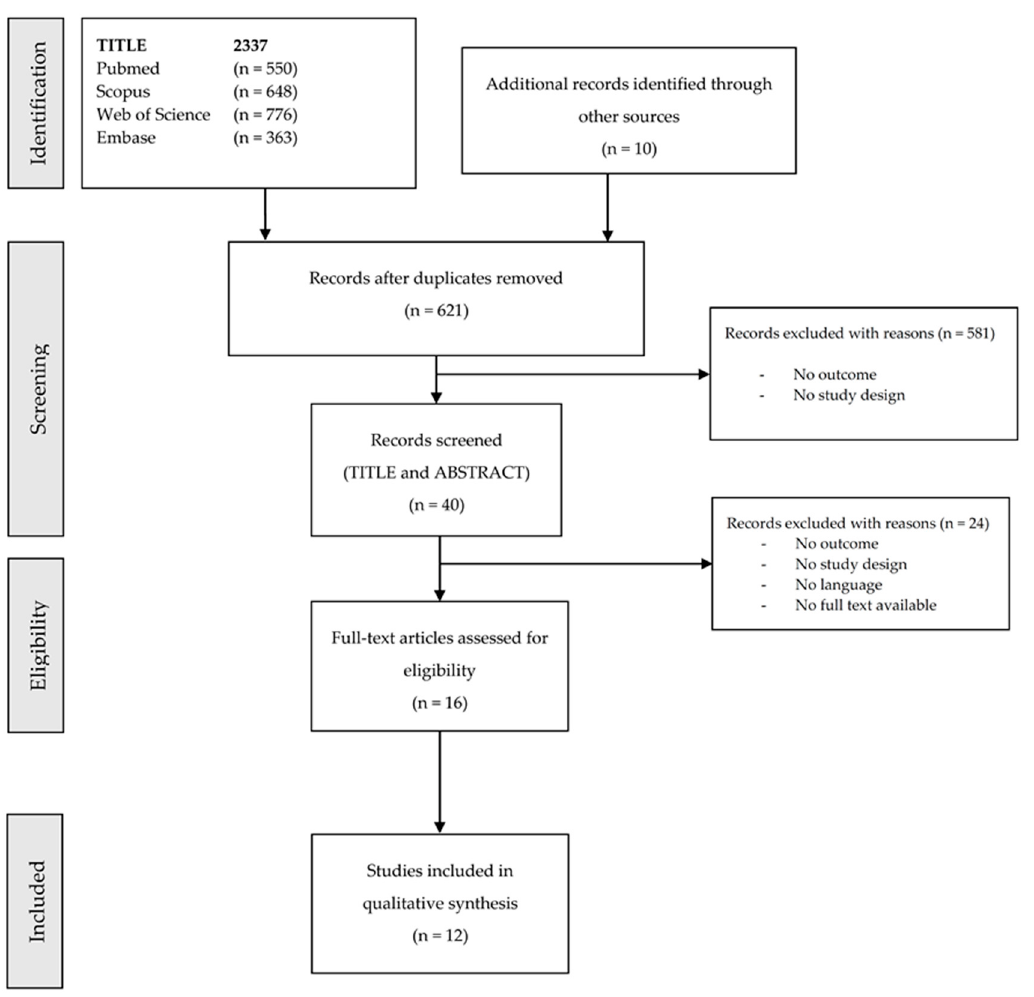
Figure 1. Flow diagram depicting the different phases of the systematic scoping review following the Preferred Reporting Items for Systematic Reviews and Meta-Analyses (PRISMA) statement.